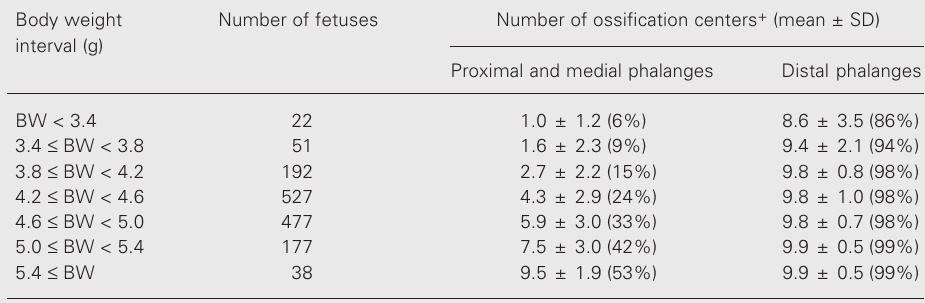
Table 6. Relationship between body weight and extent of ossification of hindlimb phalanges in rat fetuses on pregnancy day